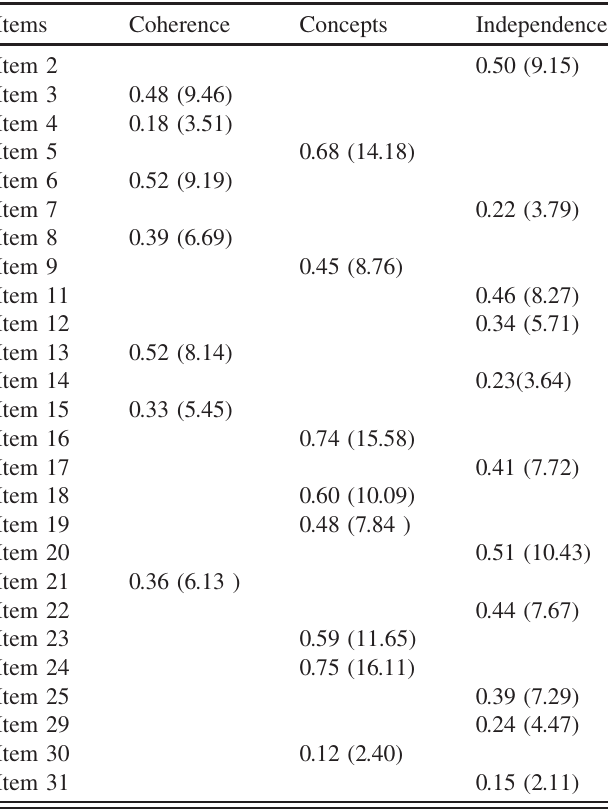
TABLE V. Standardized factor loadings ( t values) for items of the Turkish MPEX-II. (All factor loadings are significant ( p < 0 : 05 .)